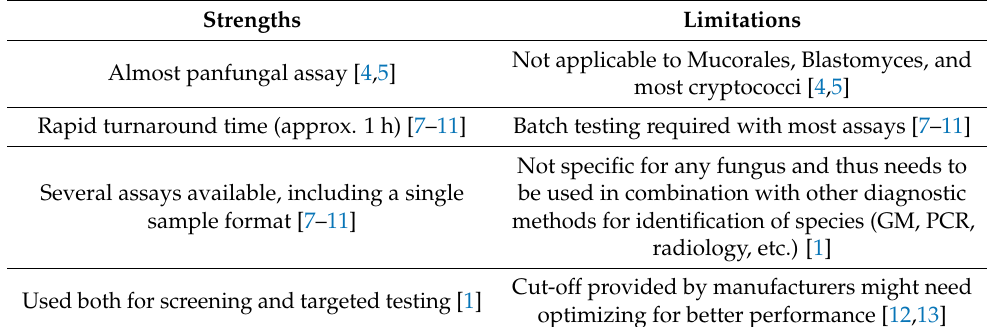
Table 4. Strengths and limitations of BDG testing in patients with haematological malignancies (HM).